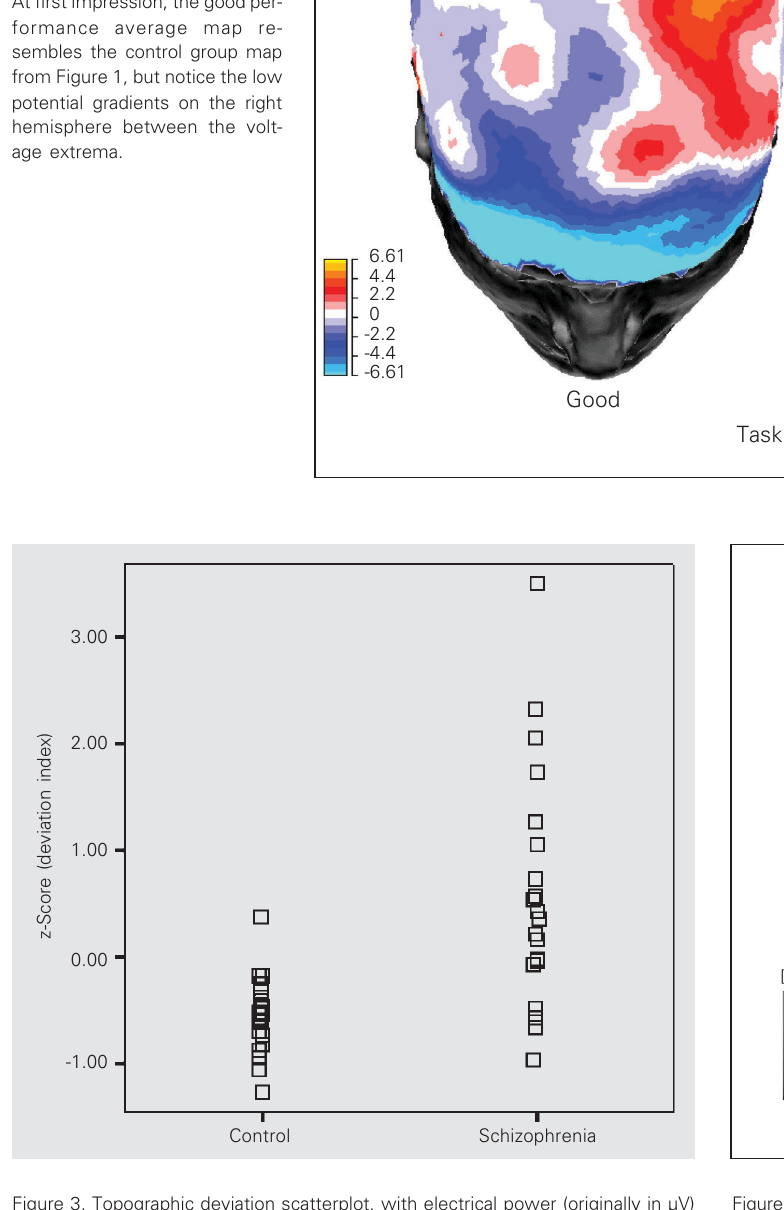
Figure 2. Topographic maps from group averaged data corre- sponding to subgroups of pa- tients with task-performance above (left, labeled good) and below the median (right, labeled poor). Scales are as in Figure 1. At first impression, the good per- formance average map re- sembles the control group map from Figure 1, but notice the low potential gradients on the right hemisphere between the volt- age extrema.